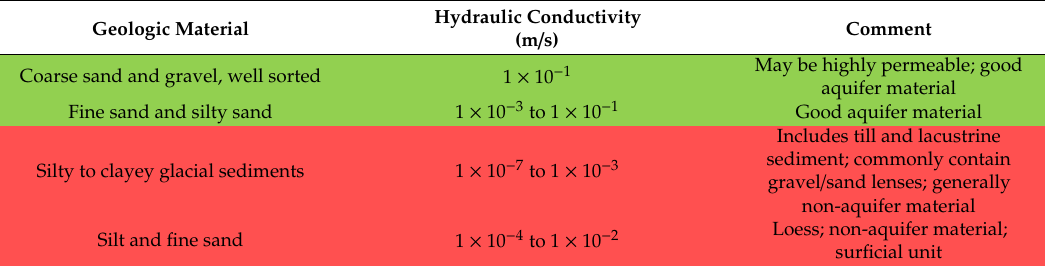
Table 1. Hydraulic conductivity of typical geologic materials in east-central Illinois [2]. Aquifer materials are shaded in green and aquitard materials are shaded in